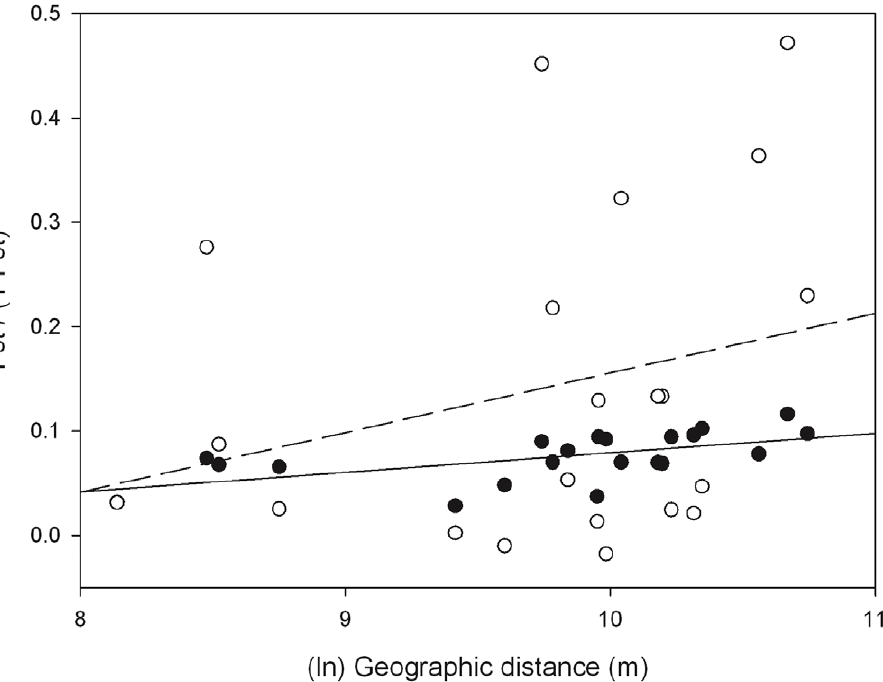
Figure 3. Regression of interindividual genetic distances a r [ 21 ] between males (a) and females (b). Regression inferred on the natural logarithm of geographic distance among individuals. Equation of males regression: y= 2 0.084 + 0.031x. Equation of females regression: y= 2 0.098 + 0.027x.